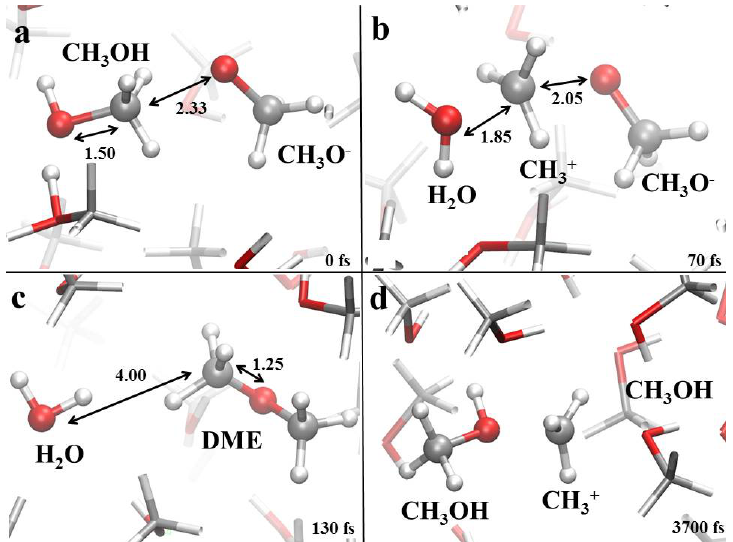
Figure 6. ( a – c ) Dimethyl ether (DME) formation mechanism in neat methanol, in the 75:25 and 50:50 methanol-water mixtures, under the action of a static electric field having intensity equal to 0.45 V/Å. ( d ) DME diffusion process through a methenium transfer mechanism. White, red, and silver